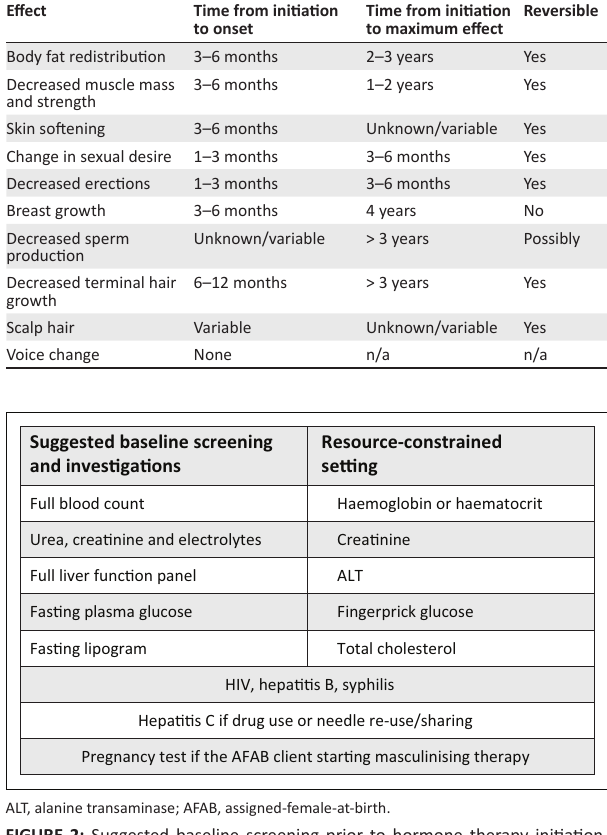
TABLE 5: Timeline and reversibility of feminising hormone therapy.